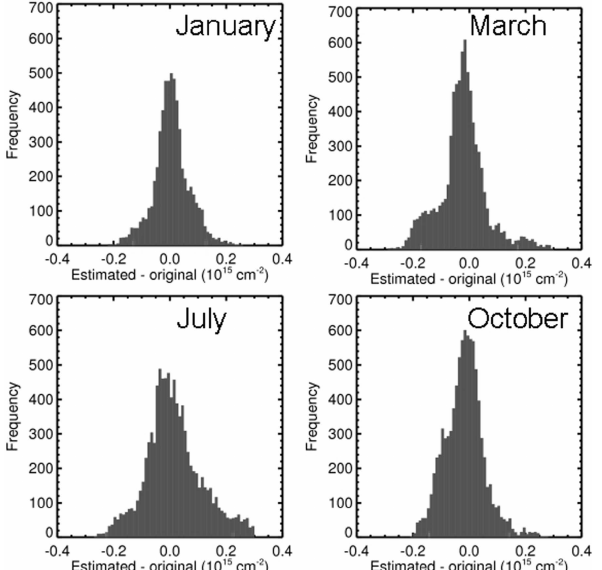
Fig. 3. Histograms of the difference between estimated and origi- nal stratospheric NO 2 columns over masked (polluted) areas based on simulated-data retrievals for January, March, July, and October 2005. Each histogram has a 2-sigma level deviation of approxi- mately 0.2 × 10 15 cm − 2 .